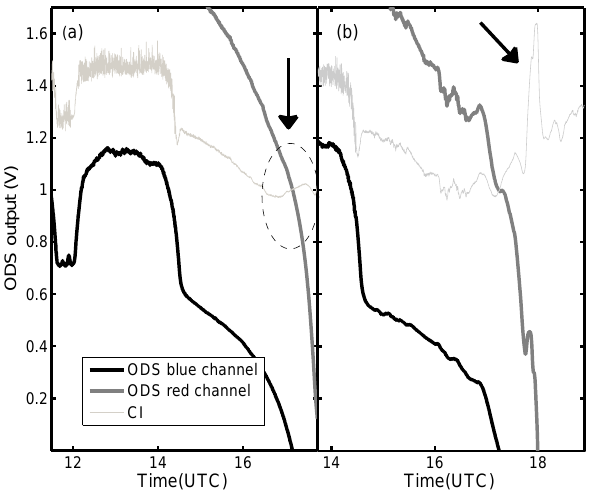
Figure 4. ODS measurement in Ouagadougou on 23 Decem- ber 2004 in cloud-free conditions. The bands delimited by the black dashed lines represent the time intervals for which the sun is within the FOV of ODS.